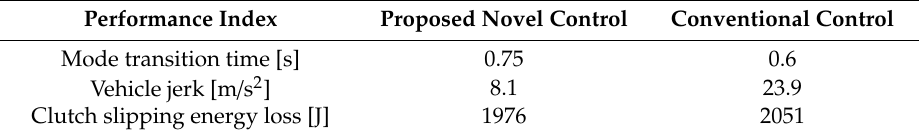
Table 3. Summary of comparison results for two methods.